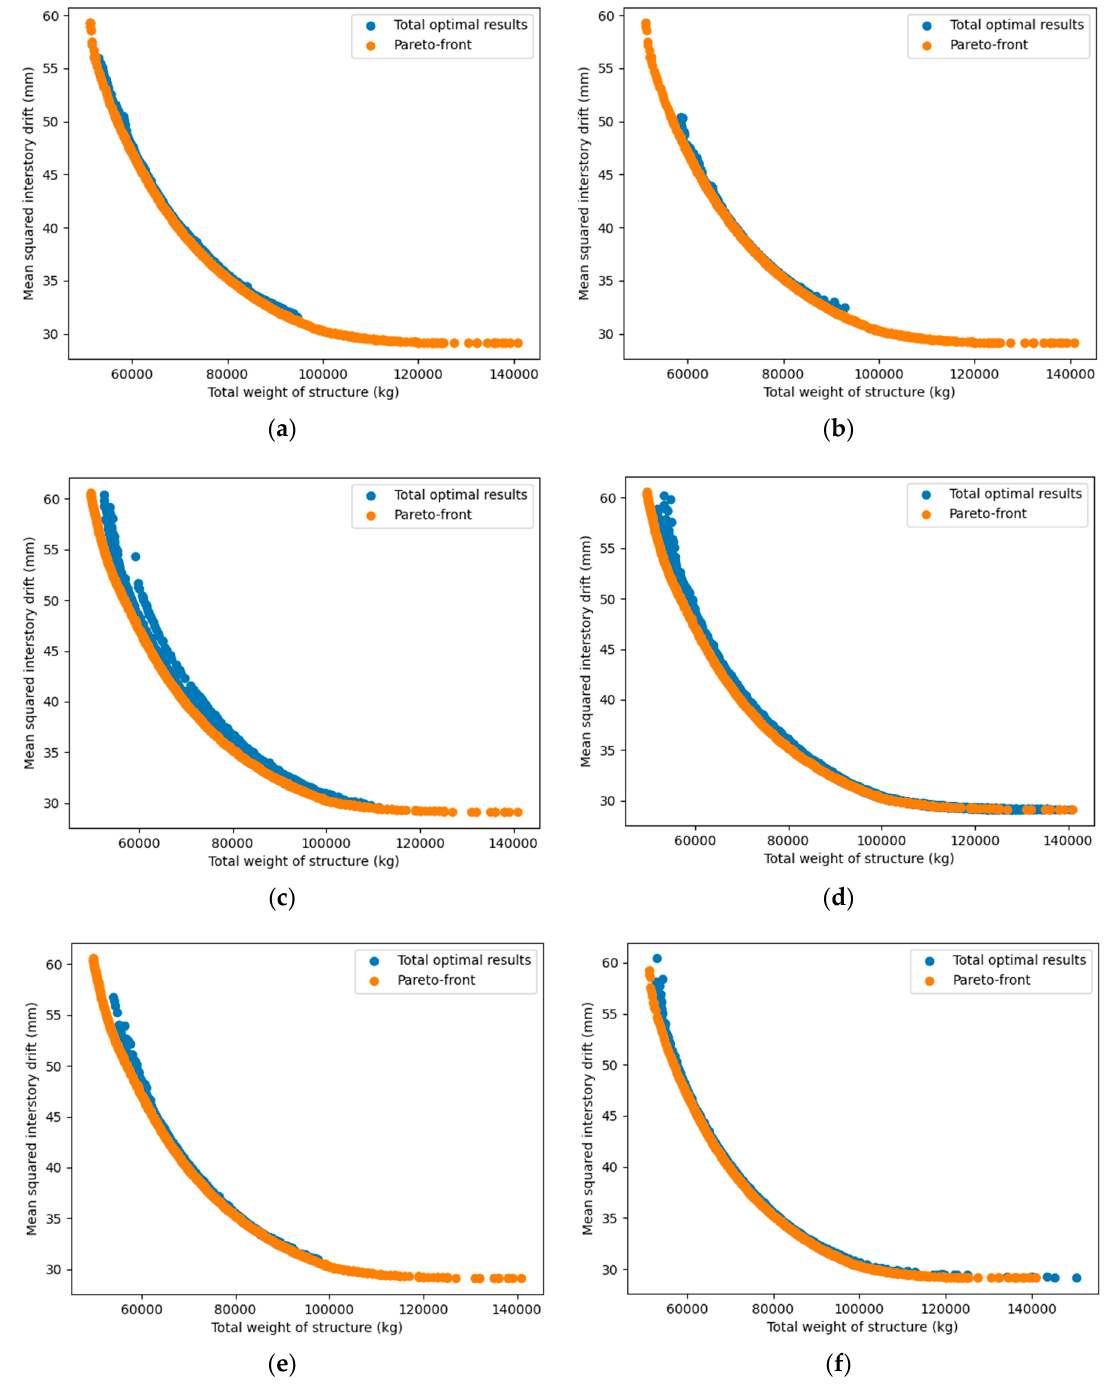
Figure 22. Paretal-front compared to the optimal solutions of the MOO algorithms in the 113-bar truss bridge: ( a ) NSGA-II; ( b ) NSGA-III; ( c ) GDE3; ( d ) OMOPSO; ( e ) SPEA2; ( f ) MOEA/D.